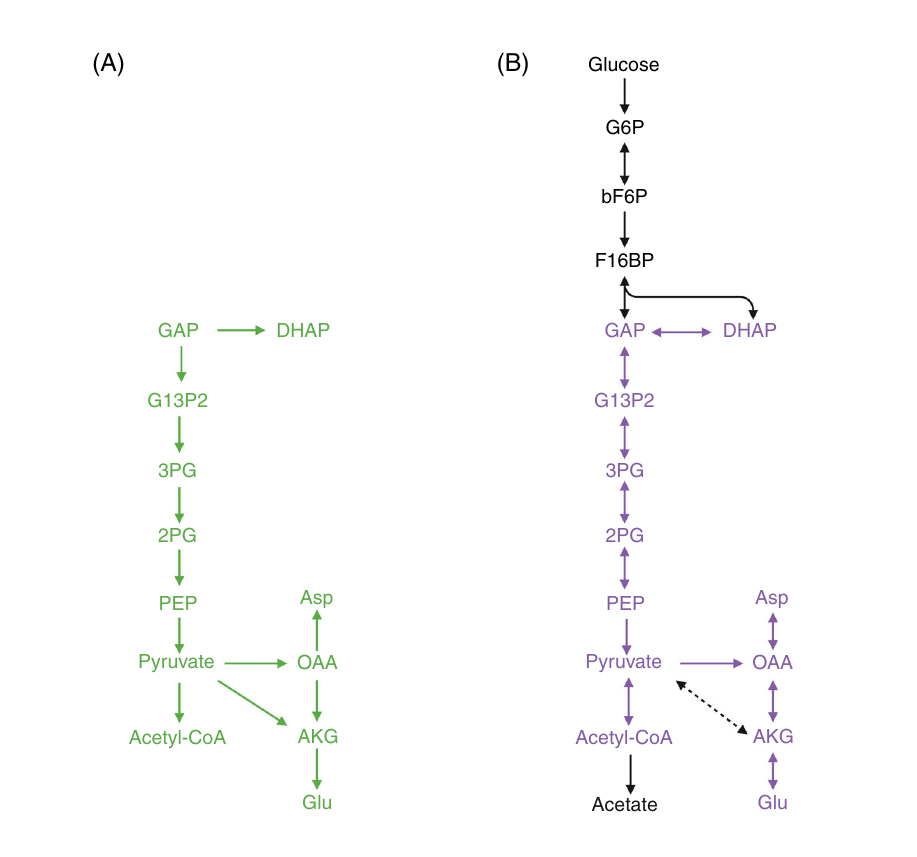
Fig. 5 | High consistency between the protometabolic pathways in prebiotic chemistry and structural conserved metabolic modules in this study. Com- parison between the proposed protometabolic pathways under ‘ prebiotically plausible ’ conditions ( A ) and central carbon metabolism in modern cells ( B